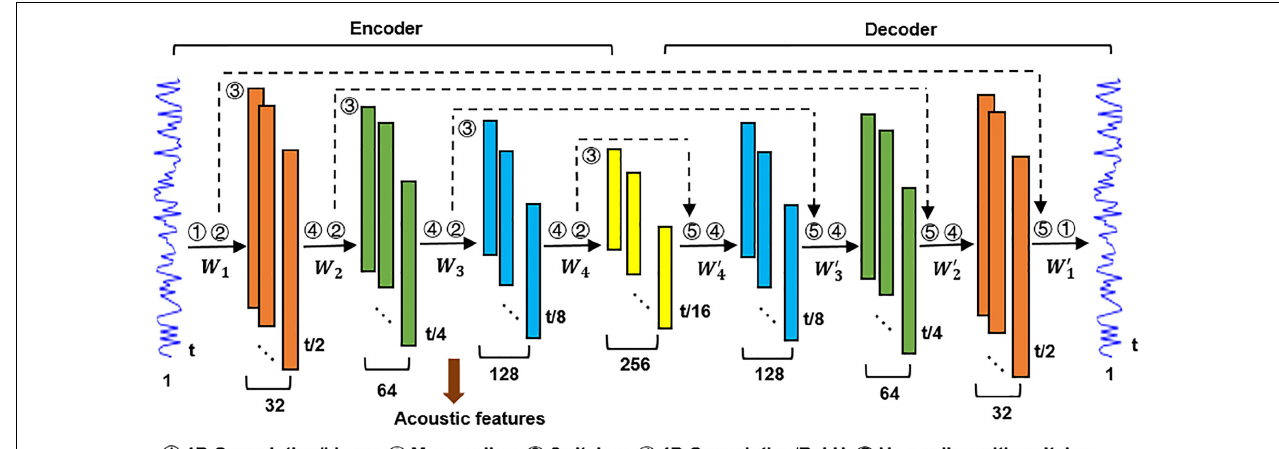
FIGURE 2 | The DCAE model used for the hierarchical feature